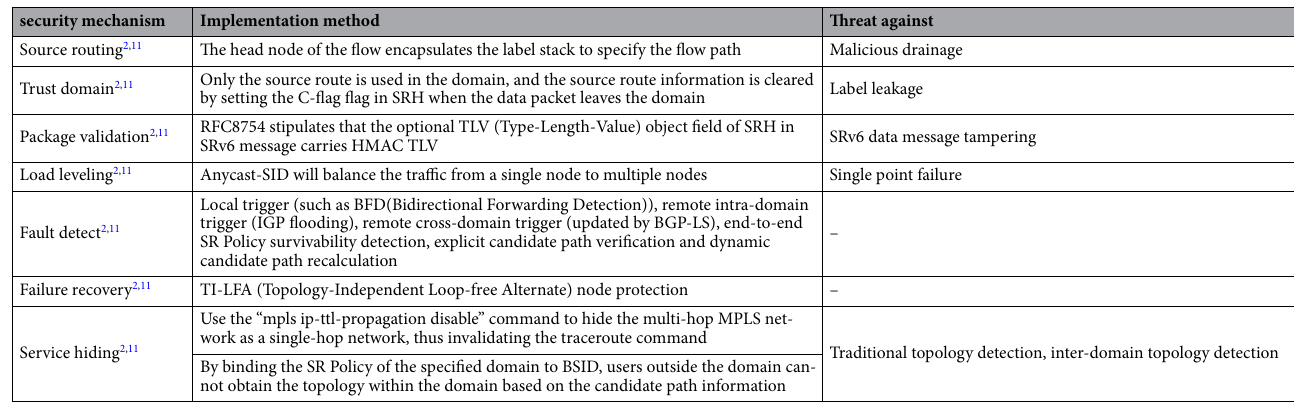
Table 1. SR native security mechanism.